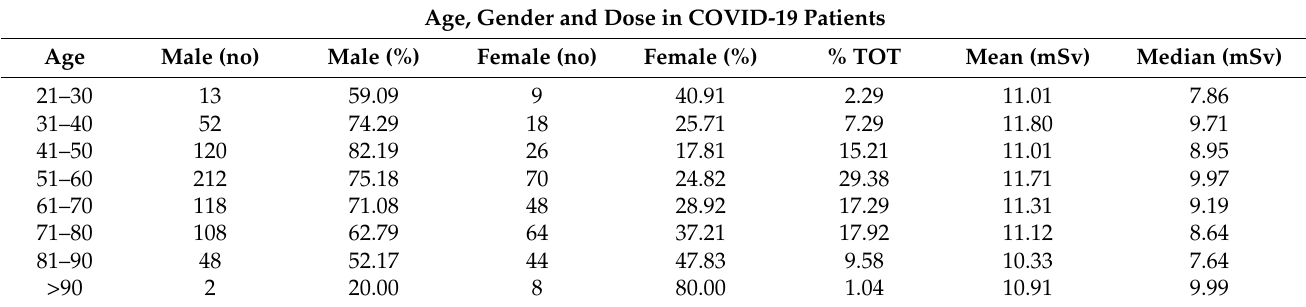
Table 1. Dose in COVID patients by age and gender. Age, Gender and Dose in COVID-19